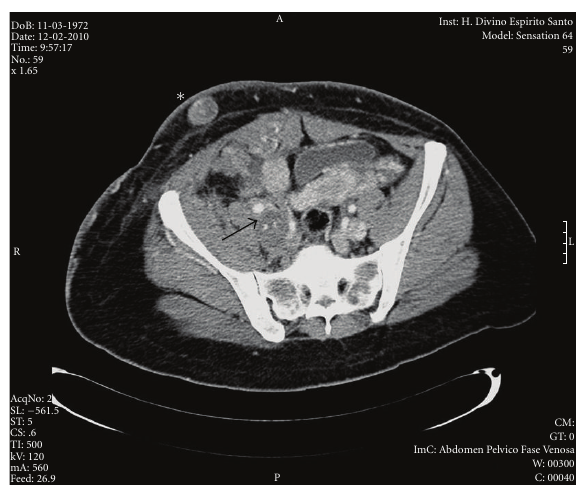
Figure 1: Abdominal and pelvic CT scan. A mass (arrow) was described as an “agglomerate of venous structures” involving a dilated right iliofemoral axis, but its tumor aetiology was not recognised. A nodule is observed but was reported as “thrombosed collateral circulation in the subcutaneous adipose plane of the ipsi- lateral inferior quadrant of the abdominal wall” ( ∗ ). The definitive diagnosis of primary venous leiomyosarcoma was obtained from a biopsy of the